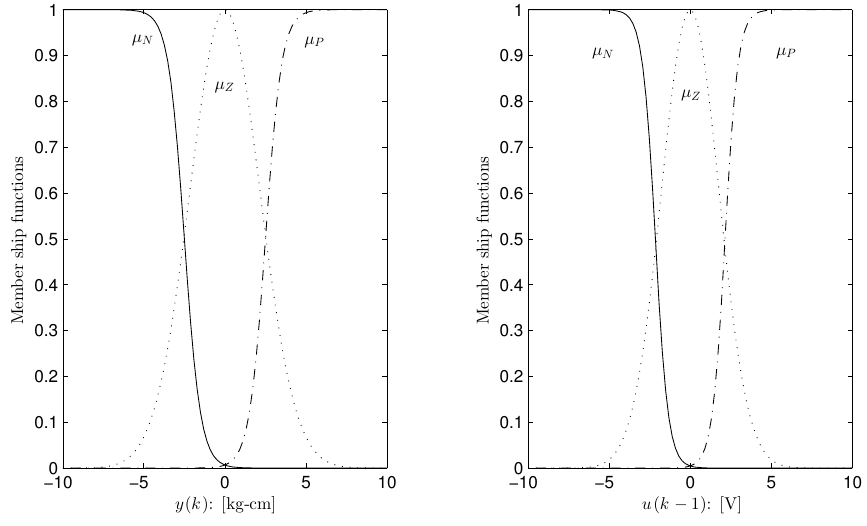
Figure 2. Membership functions.